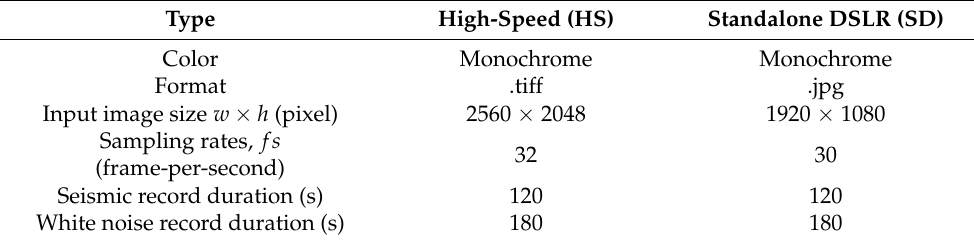
Table 7. Vision-based system configuration using two sets of cameras for the seismic shake table